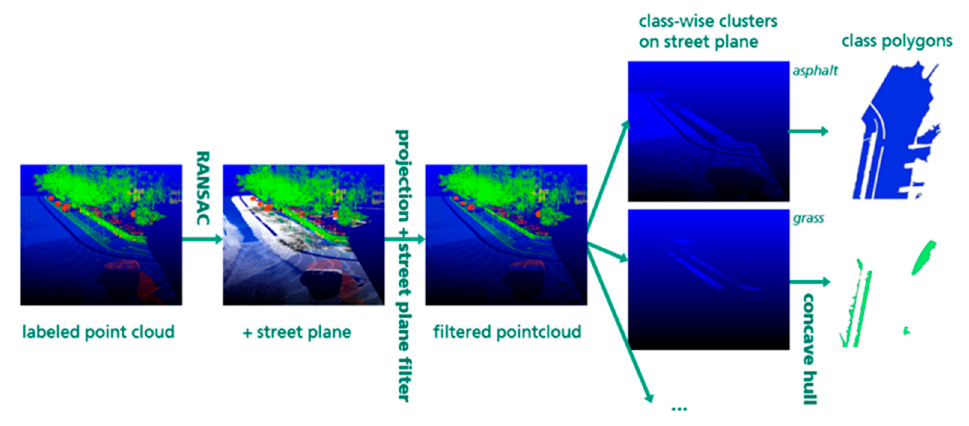
Figure 7. Detailed description of the second stage of the pipeline: After the point cloud has received the initial labels from the segmented images, we fit a plane using all points that received a surface label, the street plane (white points in the second image). The point cloud is then labeled a second time using the street plane as a filter criterion: Points on or slightly above (up to 50 cm) the street plane will only receive surface labels, not labels from background objects, such as trees or cars. This removes shadows of foreground objects caused by points “traveling through” the object due to the lower resolution of the point cloud compared to the images. We extract object point clouds from the filtered point cloud by finding clusters of points that received the same class labels with euclidean clustering. We flatten these object clusters by projection onto the street plane and compute the concave hull for each flattened object, resulting in the final object polygon.